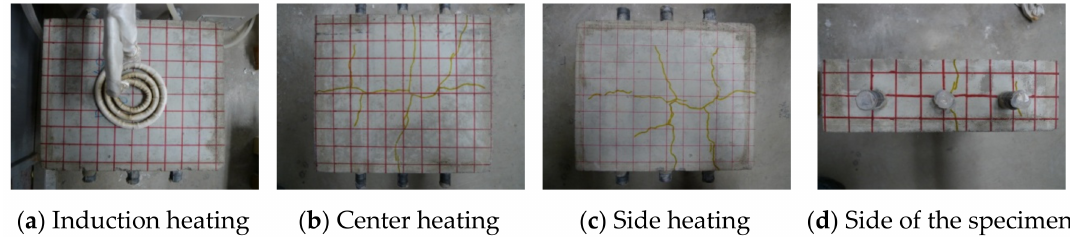
Figure 24. Cracks in cross-reinforced concrete due to induction